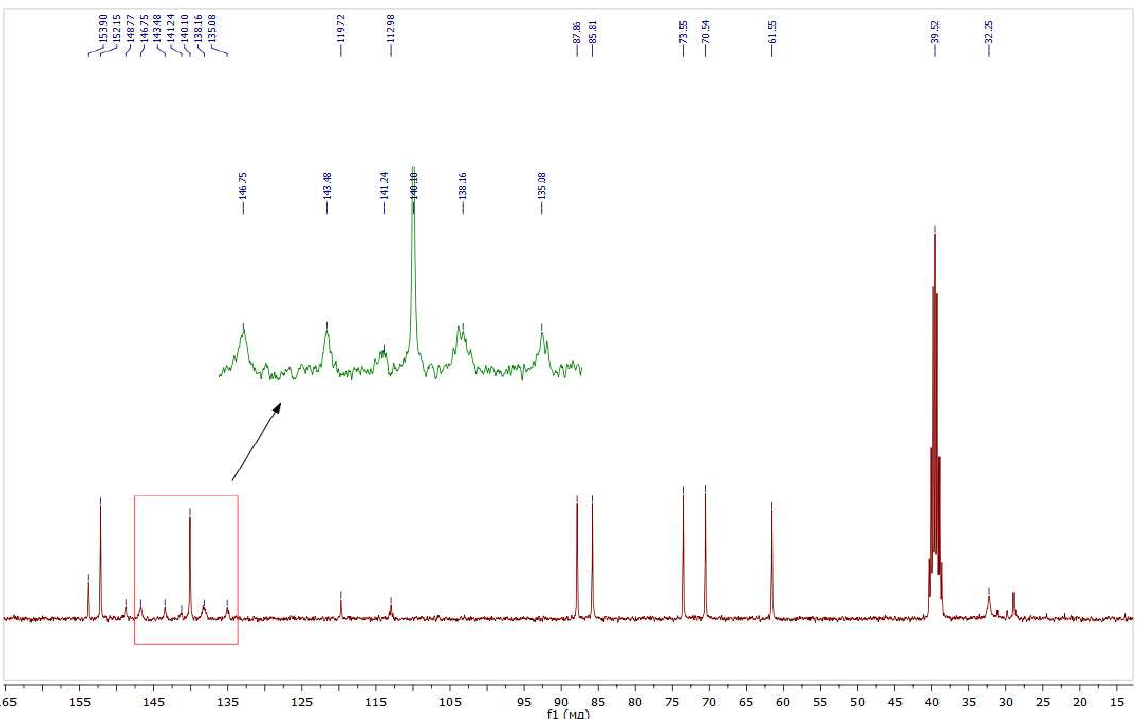
Figure 2. 13 C-NMR (75 MHz, DMSO- d 6) of substrate 1a at 293 K. The overall yield of 6a obtained by phosphorolysis of ribonucleoside 1a with further enzymatic glycosylation of base 3a in the presence of 7-Me-dGuo ( 4 ) was 28%, which was lower than in previously published procedure including arsenolysis step